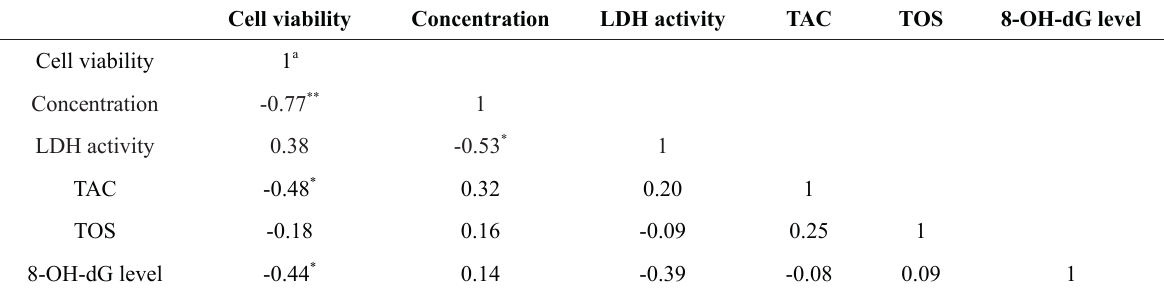
Correlation between different variables for U87MG cells exposed to